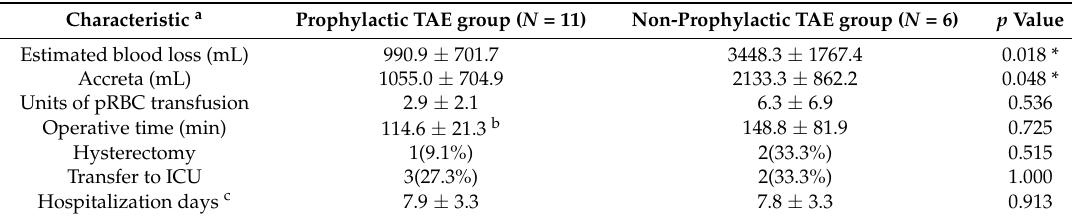
Table 2. Primary